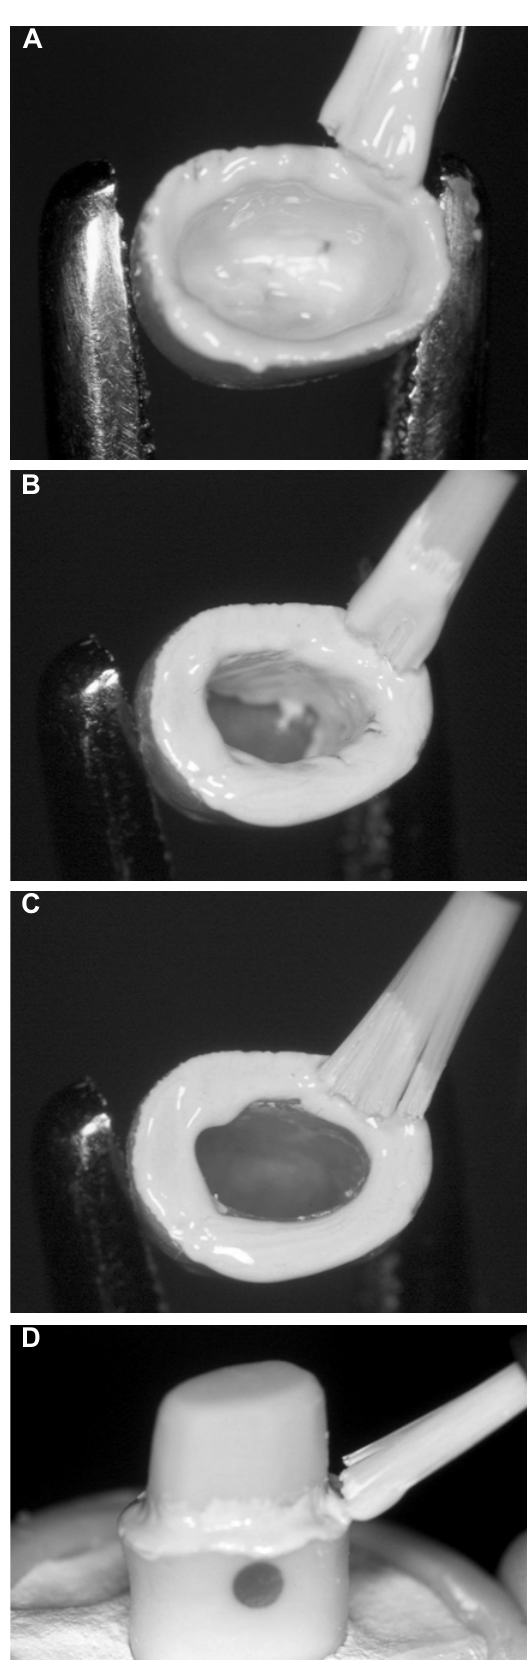
FIGURE 3- Different application sites of cement. A: crown, all axial walls and the occlusal surface. B: crown, all axial walls but the occlusal surface. C: cervical crown margin only. D: cervical tooth margin only